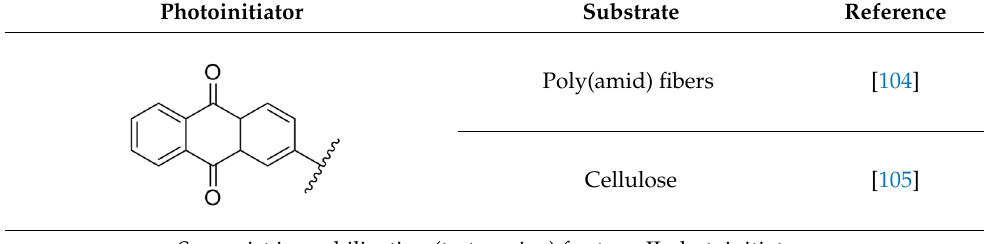
Table 1. Cont . Photoinitiator